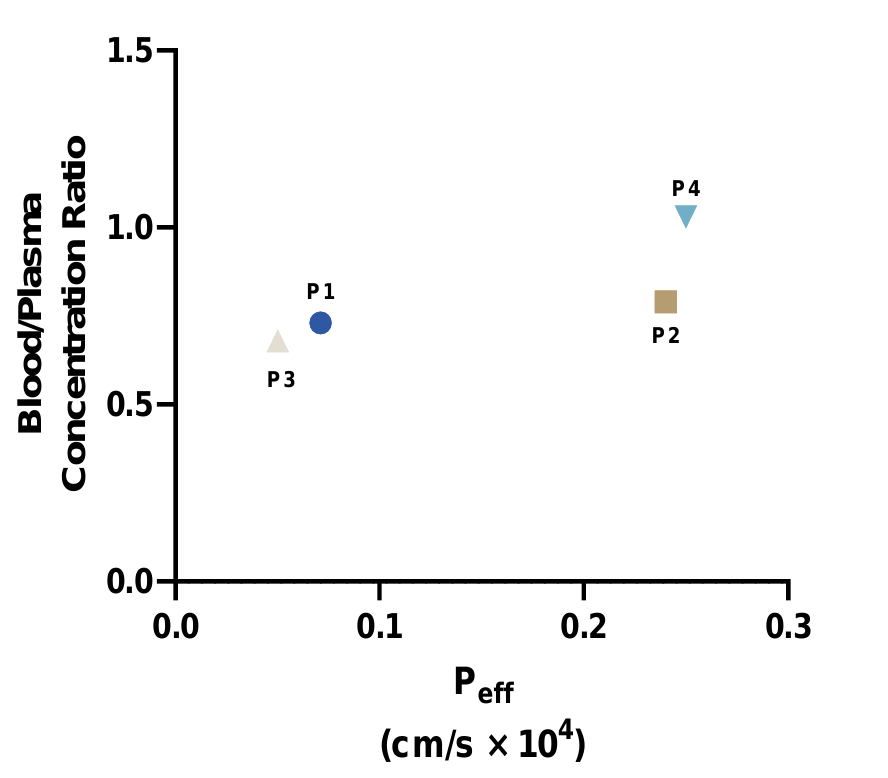
Figure 8. Representation of Blood/Plasma concentration ratio versus P eff for peptides P1 – P4.